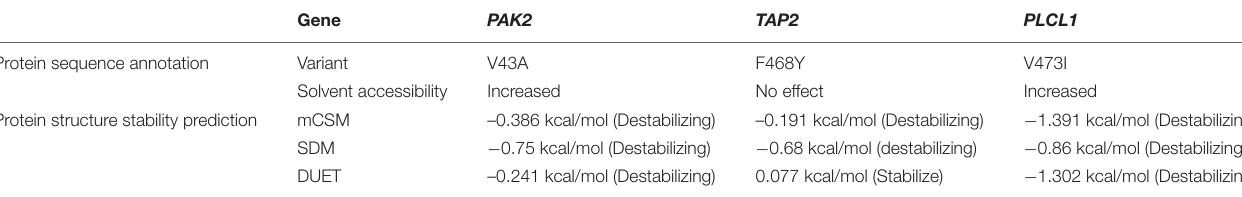
TABLE 3 | Protein sequence annotation and structural stability prediction results for PAK2, TAP2, and PLCL1. Gene PAK2 TAP2 PLCL1 Protein sequence annotation Variant